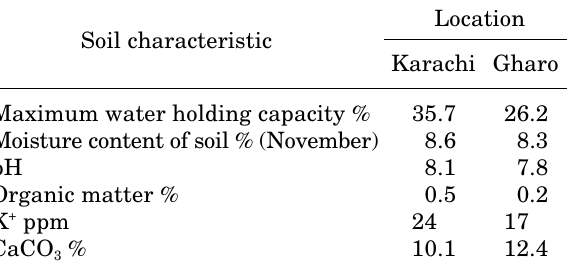
Table 1. Soil characteristics of the two locations (Kara- chi and Gharo) where the field experiments were con-